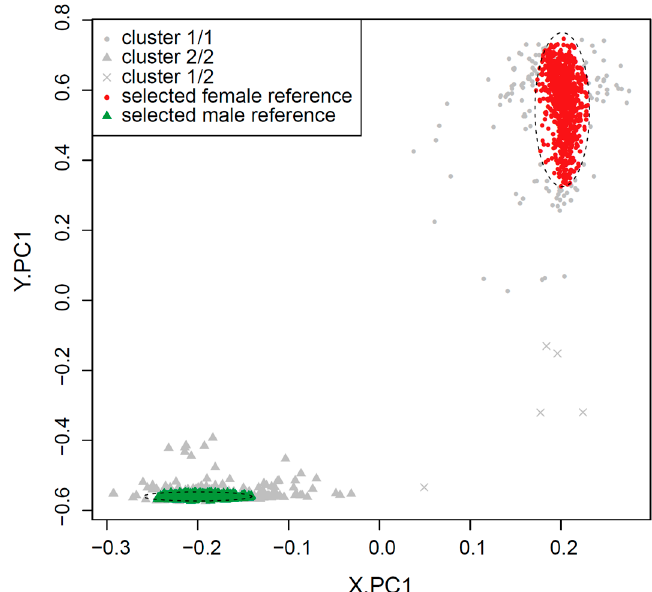
Figure 2. Selection of male and female reference samples. Randomly selected 2000 samples (1000 male and 1000 female) were plotted using the first principal component from PCA.X and PCA.Y (PCA.X on chrX and PCA on chrY, respectively), and those that were close to the centre of clusters were retained as male and female reference samples. Final reference samples are shown in color within ellipses with dashed lines. X.PC1 is the first principal component of PCA.X; Y.PC1 is the first principal component of PCA.Y.